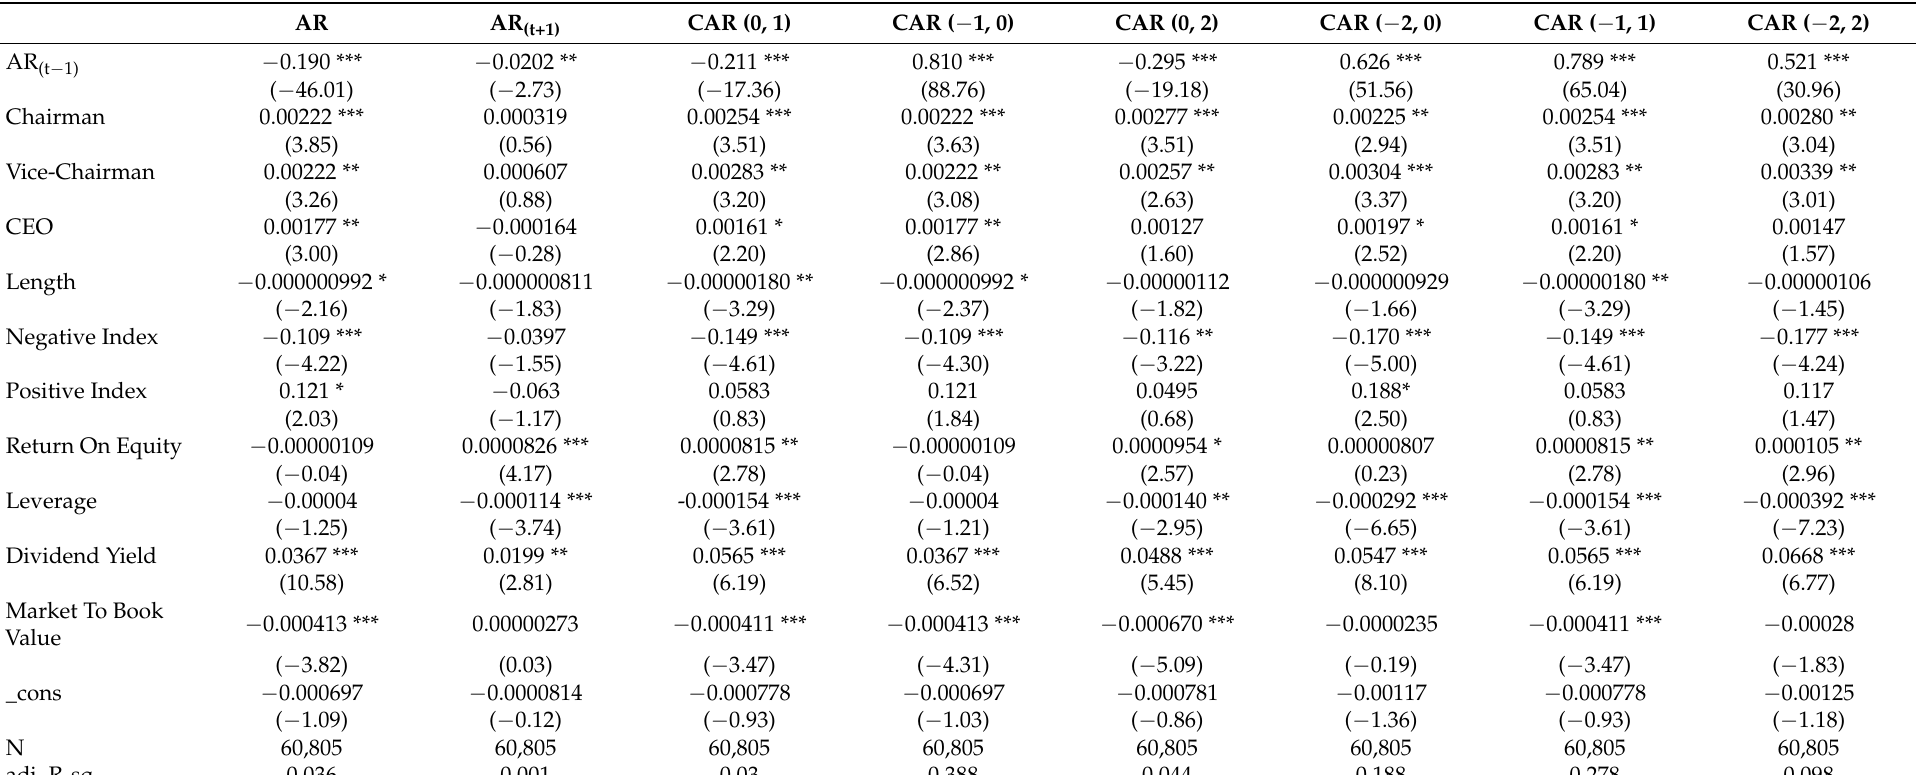
Table 7. Directors’ single roles, sentiment, and stock market